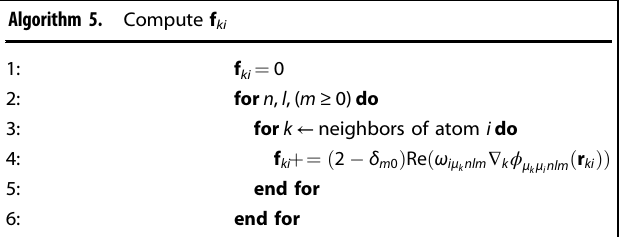
Algorithm 5. Compute f ki